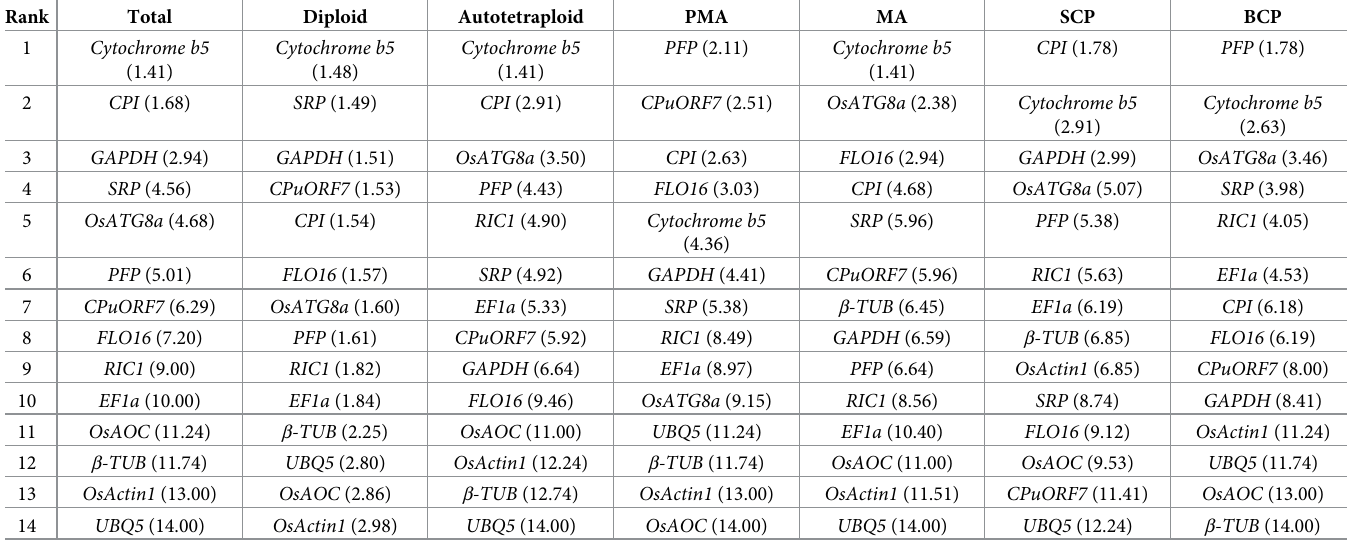
Table 5. Stability analysis of candidate reference genes assayed by RefFinder